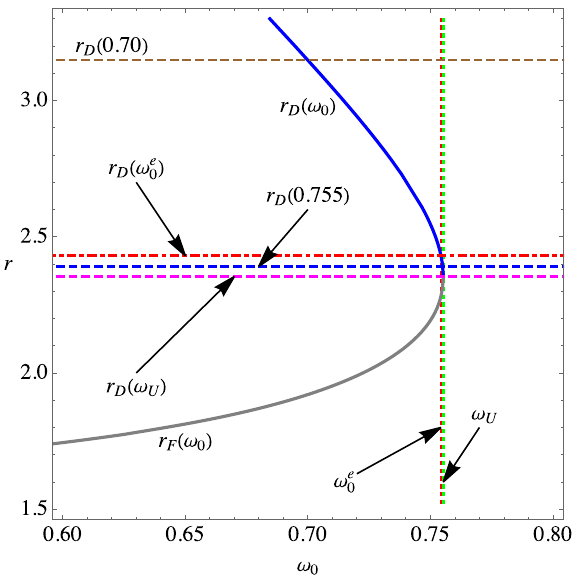
Fig. 4 The plot of r D (ω 0 ) and r F (ω 0 ) , in accordance to the values given in Fig. 3. The dashed lines indicate r D ( 0 . 70 ) , r D ( 0 . 755 ) and r D (ω U ) , and the switching radius r D (ω e line, corresponds to the starting point of a region, where the trajectories begin to change their deflecting character. In this case, ω e